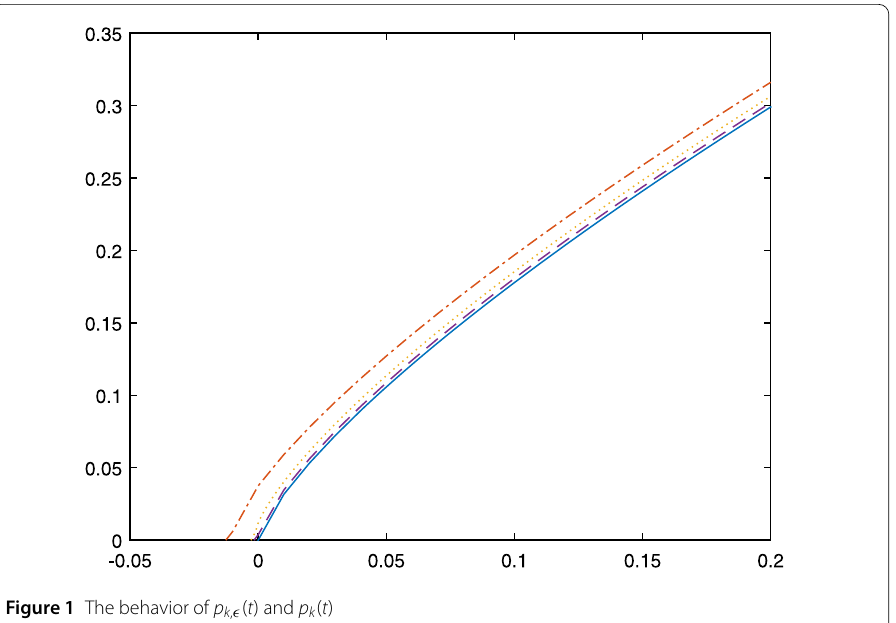
Figure 1 The behavior of p k , (cid:4) ( t ) and p k ( t